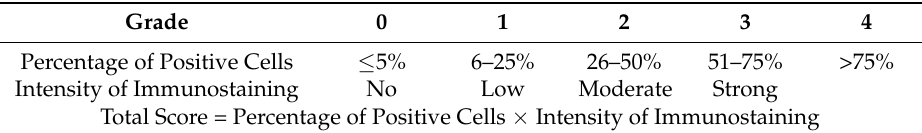
Table 3. Semi-quantitative scoring